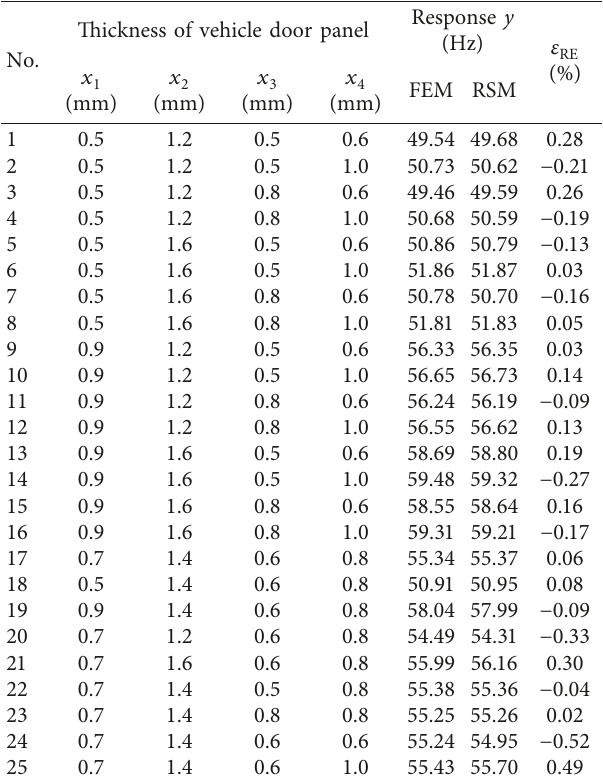
Table 4: FCCD of the fifth-order modal frequencies to design